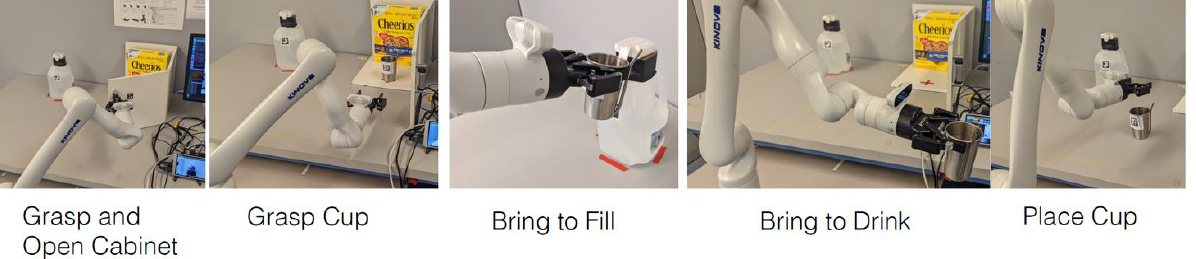
Figure 5. Subtasks for a drinking task.